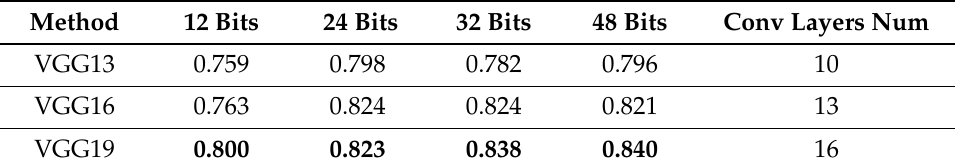
Table 4. Mean Average Precision (MAP) of Hamming ranking for different number of bits using VGG13, VGG16 and VGG19 as the fundamental feature extractors on CIFAR-10 dataset. The best results are highlighted with